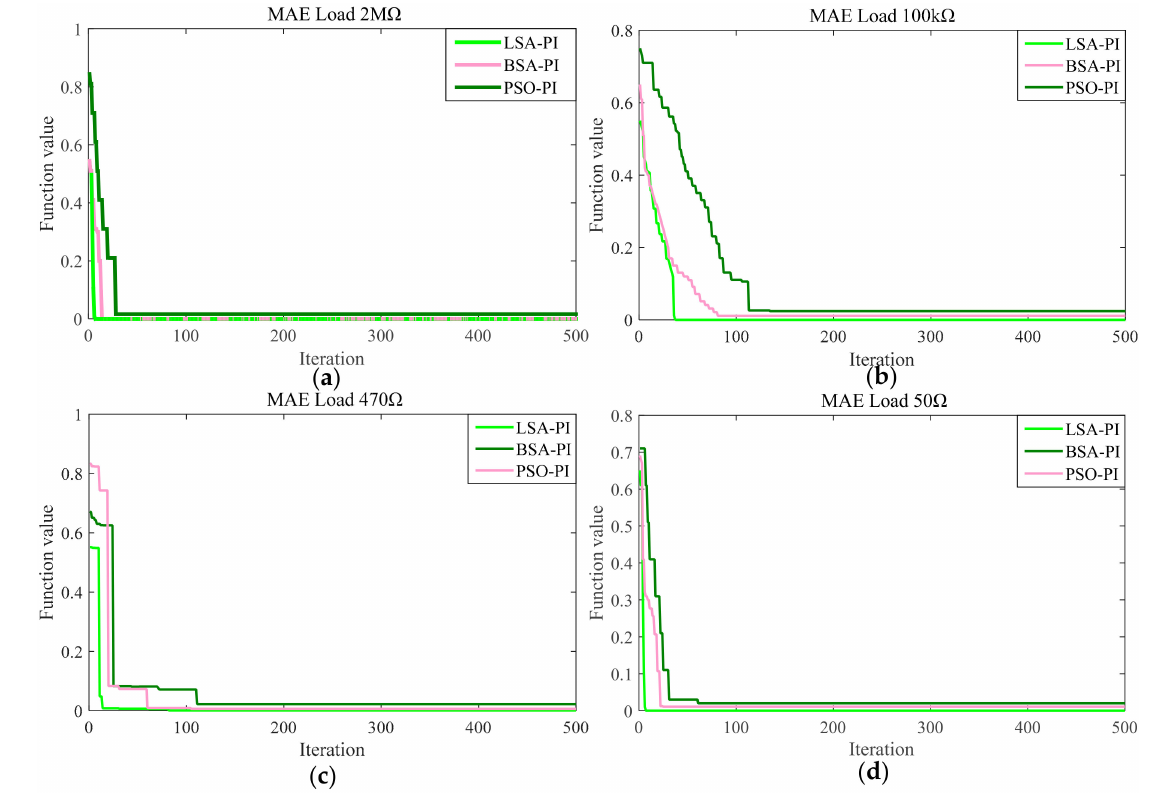
Figure 14. Convergence characteristics of optimization methods based on LSA-proportional integral (PI), backtracking search algorithm (BSA)-PI and particle swarm optimization (PSO)-PI for fitness function mean absolute error (MAE) with